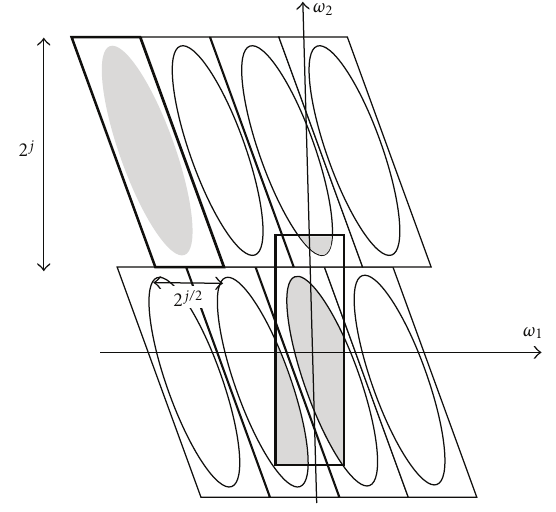
Figure 10: Wrapping wedge